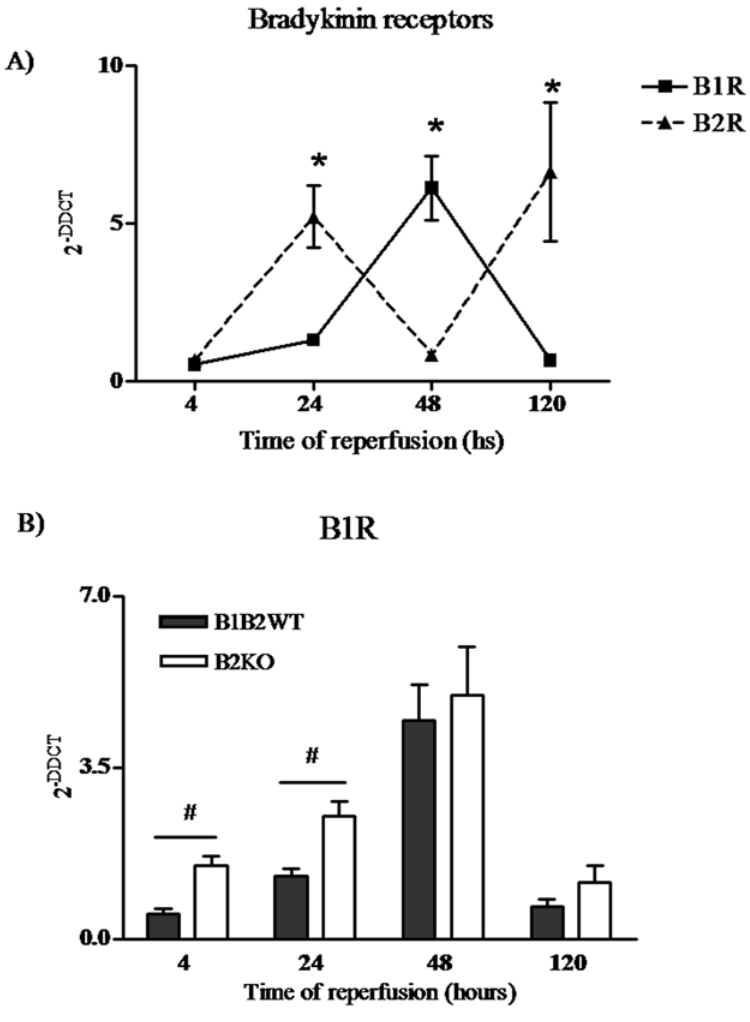
Figure 1. Renal IRI and bradykinin receptors expression. Bradykinin receptors were analyzed by real-time PCR. In B1B2WT, receptors expressions were cross-modulated (A). In B2KO, B1R expression was increased at 4 and 24 hours (B). Statistical analyses were performed by ANOVA. *B1R versus B2R, p , 0.05. # B2KO versus B1B2WT, p , 0.05. doi:10.1371/journal.pone.0003050.g001 PLoS ONE |